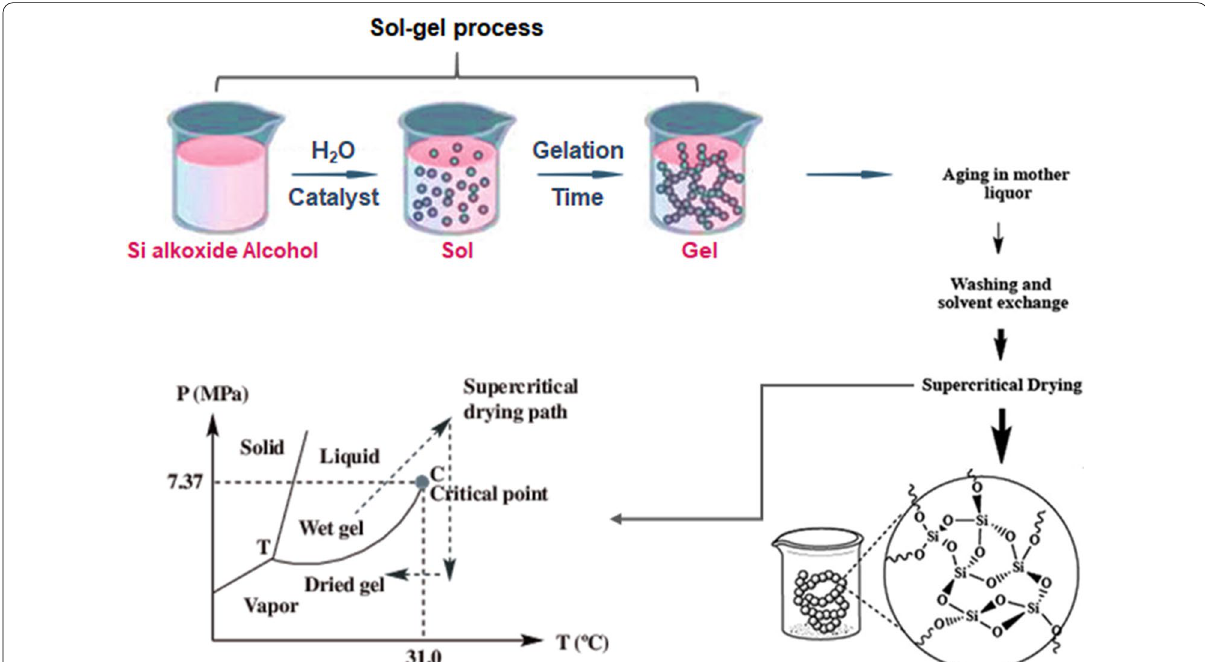
Fig. 1 Schematic process of typical sol–gel synthesis [28] Copyright 2014 Journal of Non-Crystal